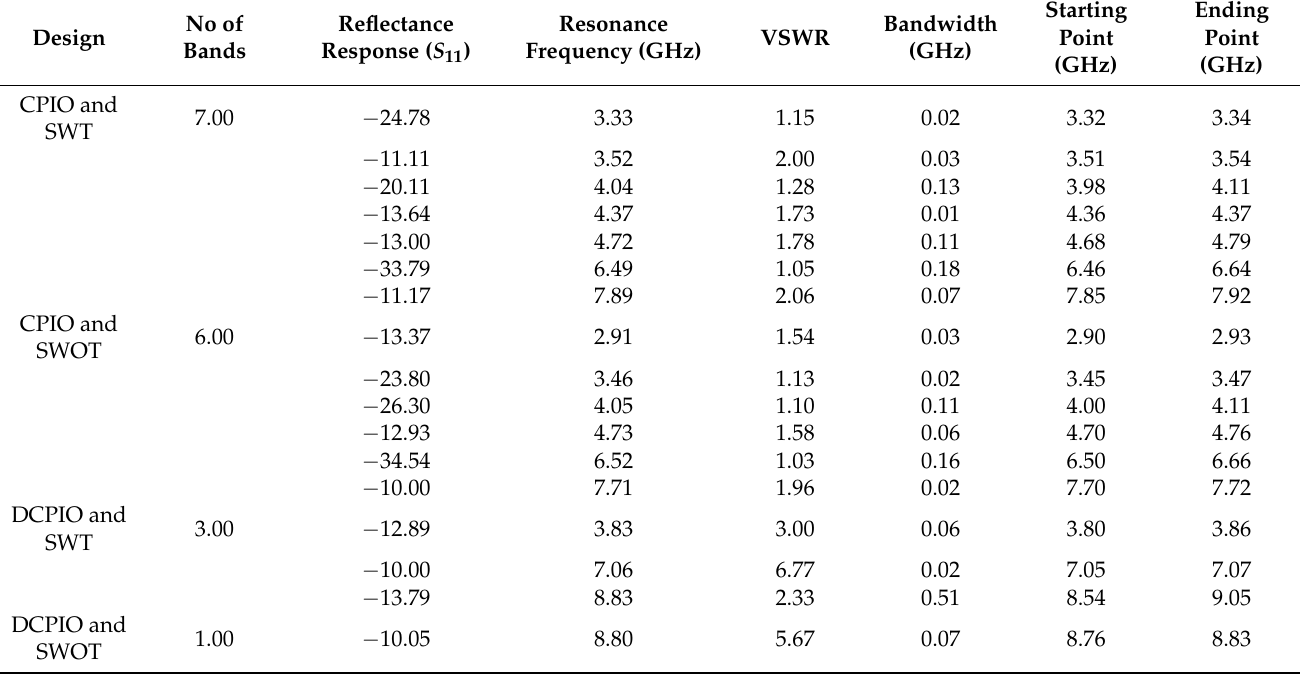
Figure 8. ( a ) The minimum value of the VSWR for the proposed four antenna structures by selecting the substrate as FR4 ,is 1.51 at 3.38 GHz, 1.18 at 3.39 GHz, 1.83 at 7.27 GHz, respectively, and 2.21 at 8.64 GHz. ( b ) The minimum value of the VSWR for the proposed four antenna structures by (Substrate – FR4 ) (Substrate - ROGER RT Duroid 5880 )